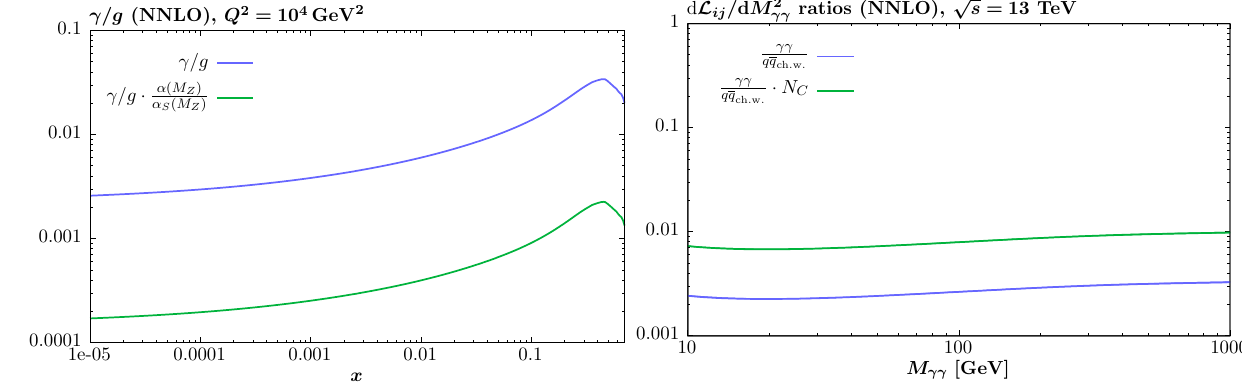
Fig. 1 (Left) The ratio of the γ to the g distributions at Q 2 = 10 4 GeV 2 .Inadditionthesameratio,butweightedby α( M Z )/α S ( M Z ) , is shown. (Right) Ratio of the γγ to the charge weighted qq luminosity